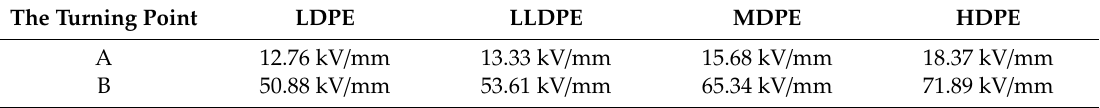
Table 4. The corresponding field strength at di ff erent turning points of di ff erent